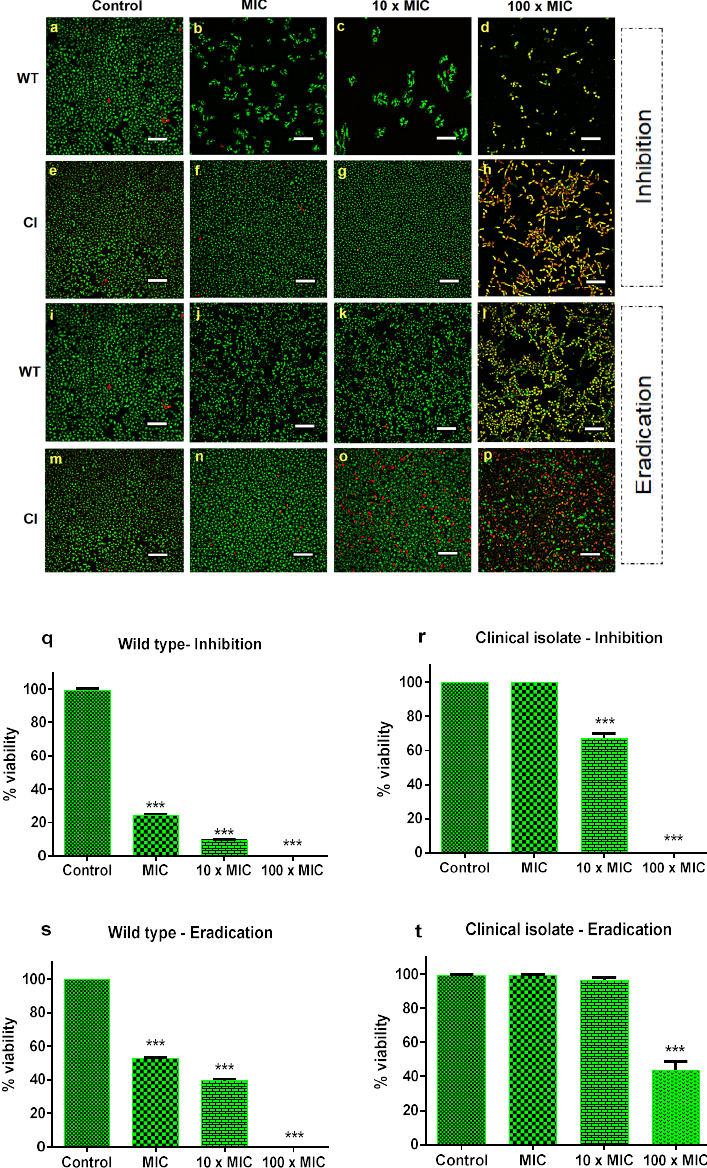
Figure 1. Effect of Ctn[15–34] on the inhibition and eradication of C. albicans biofilms. Confocal microscopy images of the inhibition of C. albicans biofilms for the sensitive wild-type strain ( a – d ) and the drug-resistant clinical isolate strain ( e – h ), and biofilm eradication of wild-type ( i – l ) and clinical isolate ( m – p ), in the absence (control) and presence of Ctn[15–34] at di ff erent concentrations. Images obtained with live / dead staining (SYTO 9, green; PI, red) using 40-fold magnification. Scale bars: 30 µ M. Quantification of viable cells ( q – t ) obtained using the ImageJ software. Bars represent mean ± SD. *** p < 0.001 relative to control (without peptide).